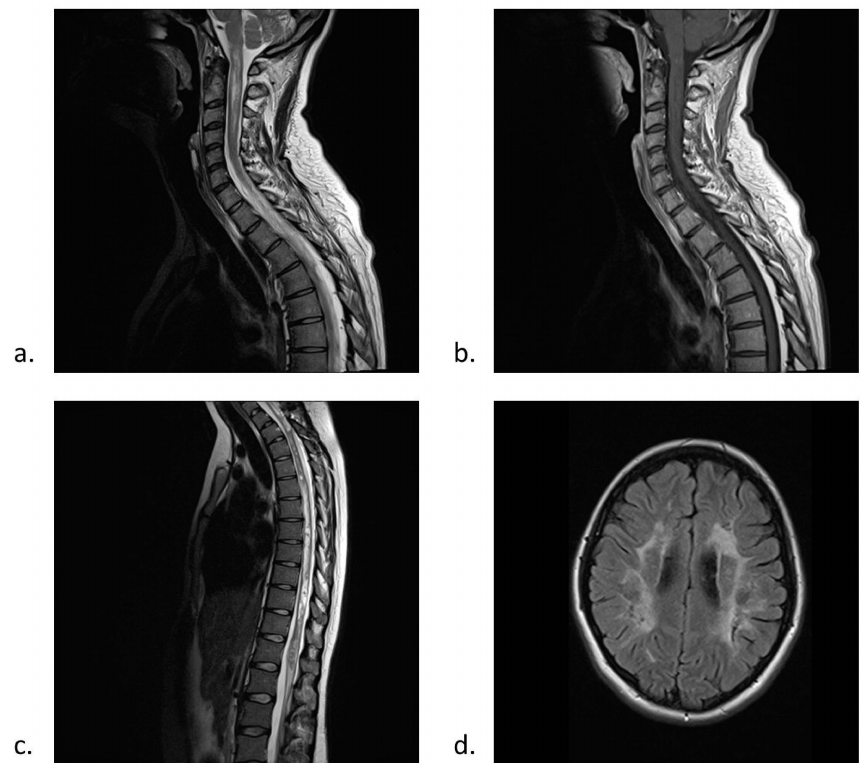
Figure 2. Neuroradiology of neuromyelitis optica spectrum disorder (NMOsd): ( a , b ) magnetic resonance imaging (MRI) visualisation of cervical spinal cord lesions in a 51-year old female with AQP4-IgG (+) NMOsd; ( a ) longitudinally extensive, central, extending to brainstem T2-hyperintense lesion; ( b ) corresponding T1-hypointensities, representing focal spinal cord atrophy; ( c , d ) thoracic spinal cord and brain MRI lesions in a 20-year old AQP4-IgG (+) female with NMOsd; ( c ) nearly complete central longitudinal thoracic spinal cord NMO involvement; ( d ) brain lesions on FLAIR (fluid-attenuated inversion recovery) images that do not fulfill multiple sclerosis diagnostic criteria. Images from the collection of Department of Neurology, Poznan University of Medical